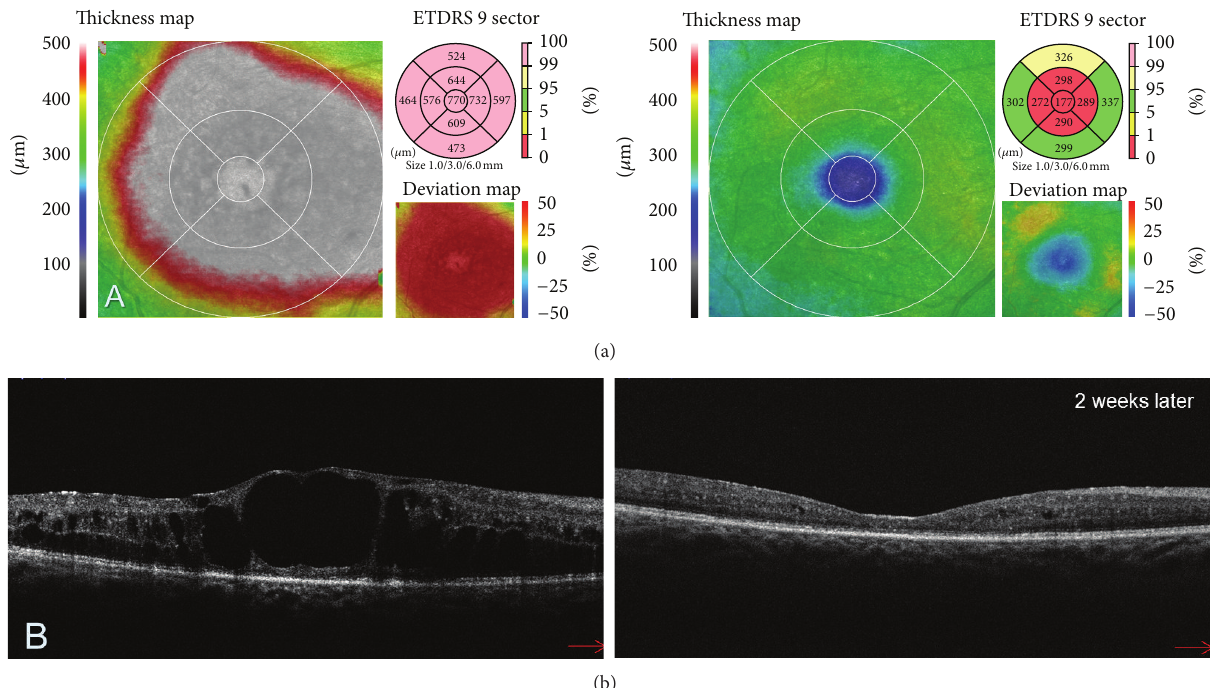
Figure 3: (a) Colour-coded macular thickness maps revealing the change in retinal thickness between the examinations. The second map was obtained 2 weeks after treatment with Ranibizumab. Resolution of DME is evident but the corresponding thickness deviation map shows that the anatomical improvement is also related to the central macular atrophy which may limit the visual acuity. (b) Corresponding SDOCT tomograms presenting the disappearance of nearly all intraretinal cystoid